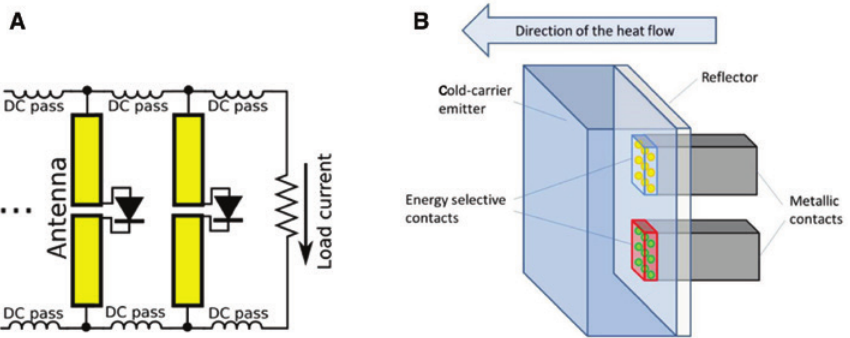
Figure 13: (A) Design of a rectenna-based EEH, where the electrical signal is coupled to IR radiation collected by antennas. (B) Illustration of a cold carrier EEH. Electrical current is extracted by energy-selective metallic contacts. The back reflector is used to reduce radiative heat transfer between the cold electrons and the heat source. Reproduced from [76], with the permission of AIP